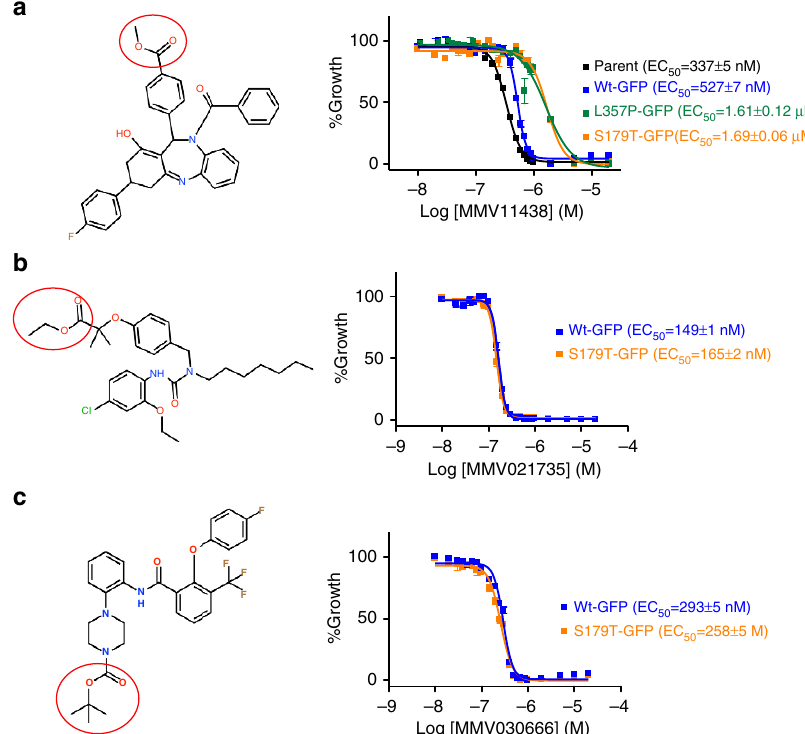
Figure 4 | PfPARE hydrolyzes and activates an ester-containing prodrug. Concentration-responses against 3D7 asexual parasites (right) and structures (left) of compounds from the MDTIP consortium 16 . EC 50 values were measured with a flow cytometry-based assay. Parasite strains are labelled black (3D7), blue ( pfpare wild-type allelic exchange), green ( pfpare L357P allelic exchange) and orange ( pfpare S179Tallelic exchange). Inhibition data were fit to a sigmoidal concentration-response curve. ( a ) MMV011438, ( b ) MMV021735, ( c ) MMV030666. In a , F-test; P o 0.0001 for S179Tor L357P compared to Wt. Error bars show s.d. ± indicates standard errors calculated for the biological triplicates of the experiment shown. N ¼